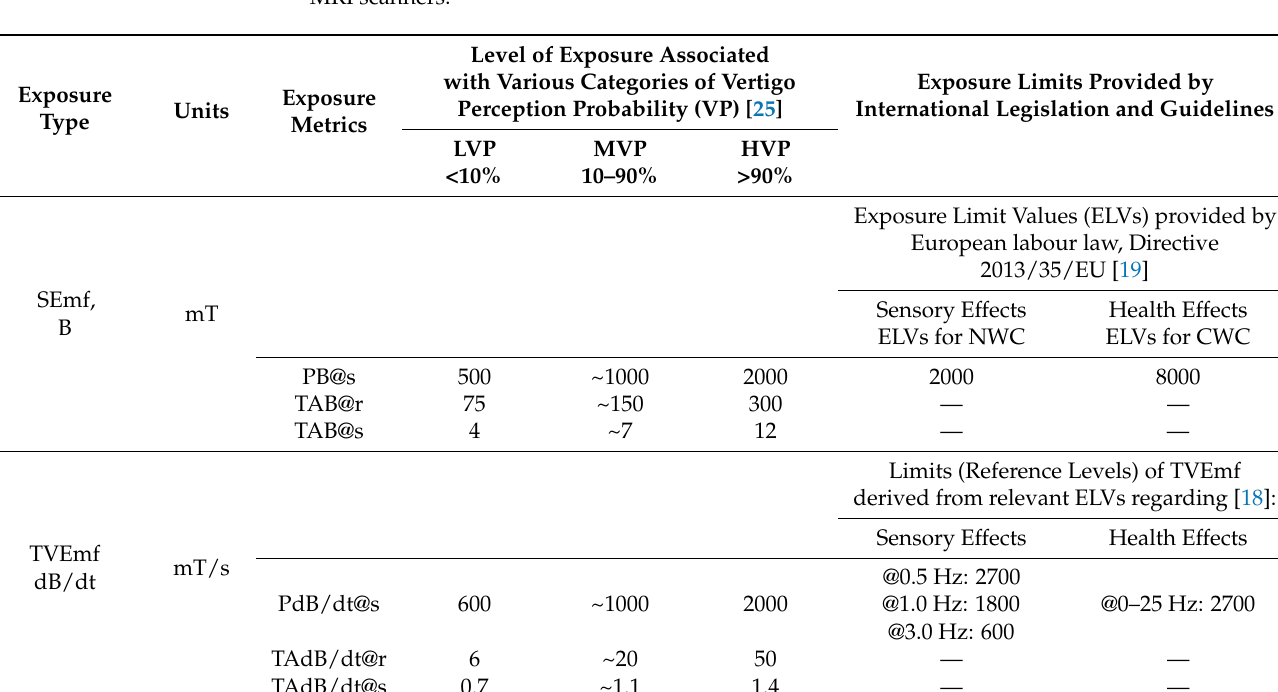
Table 1. Criteria for evaluating exposure among healthcare personnel to static magnetic fields near MRI